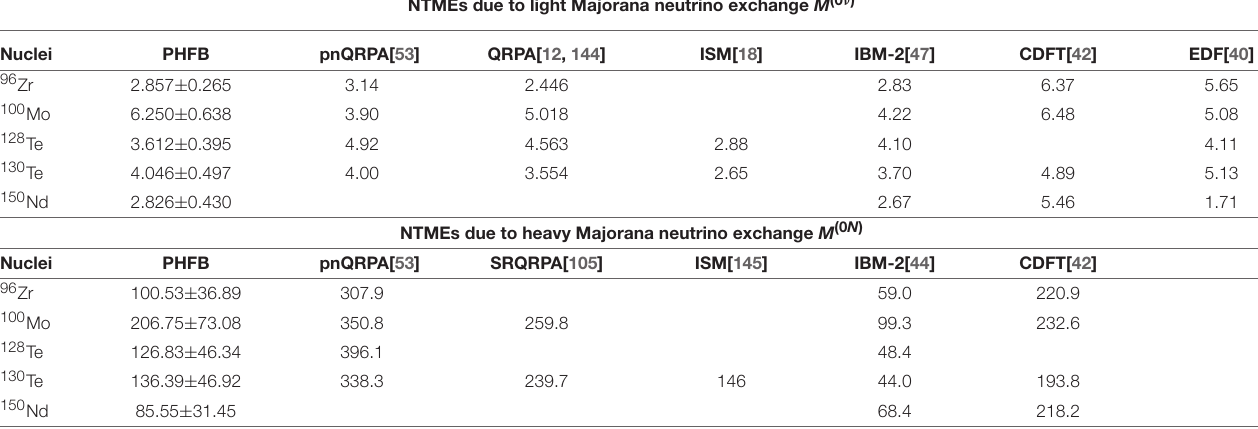
TABLE 7 | Comparison of NTMEs due to light Majorana neutrino exchange M (0 ν ) and heavy Majorana neutrino exchange M (0 N ) calculated within PHFB model (case (a)) for 96 Zr, 100 Mo, 128,130 Te, and 150 Nd isotopes with those of other models.